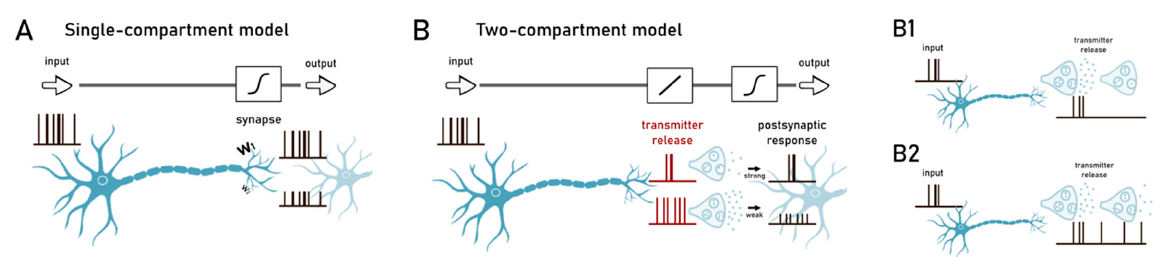
Figure 2. Synaptic modeling: ( A ) Single compartment synapse acting as a linear multiplier of incoming input. Despite its simplicity, this model lies at the basis of a wide range of computational models of circuit function. ( B ) Two-compartment models. Presynaptic terminal is believed to behave as a frequency filter able to perform complex forms of temporal filtering discriminating firing patterns while the postsynaptic element controls the gain to modulate neuronal response. ( B1 ) Another level of complexity in modeling synaptic transmission is related to neurotransmitter diffusion. Here synchronous release of neurotransmitters is represented; ( B2 ) asynchronous release of neurotransmitters.